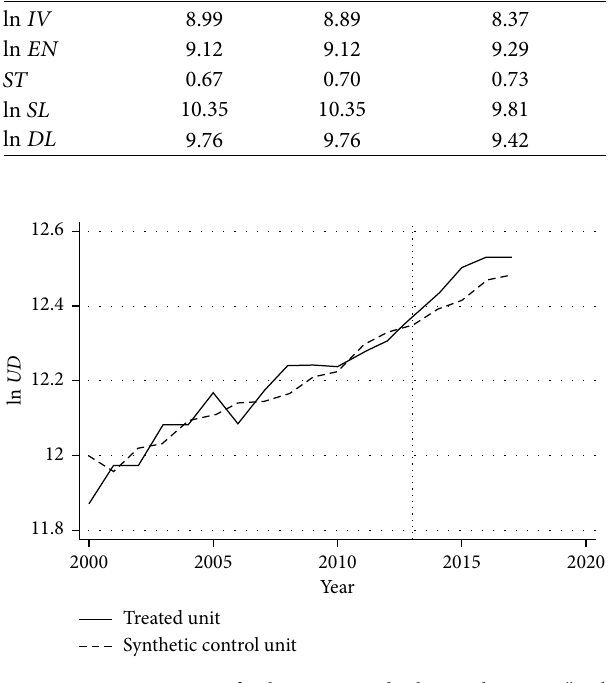
Figure 4: Comparison of urban sewage discharges between “real Zhejiang” and “synthetic Zhejiang”.